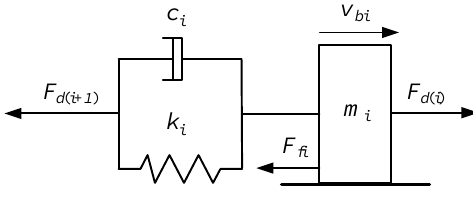
Figure 7. A belt unit model. The dynamic equation of a belt unit model is expressed as Equation (16).